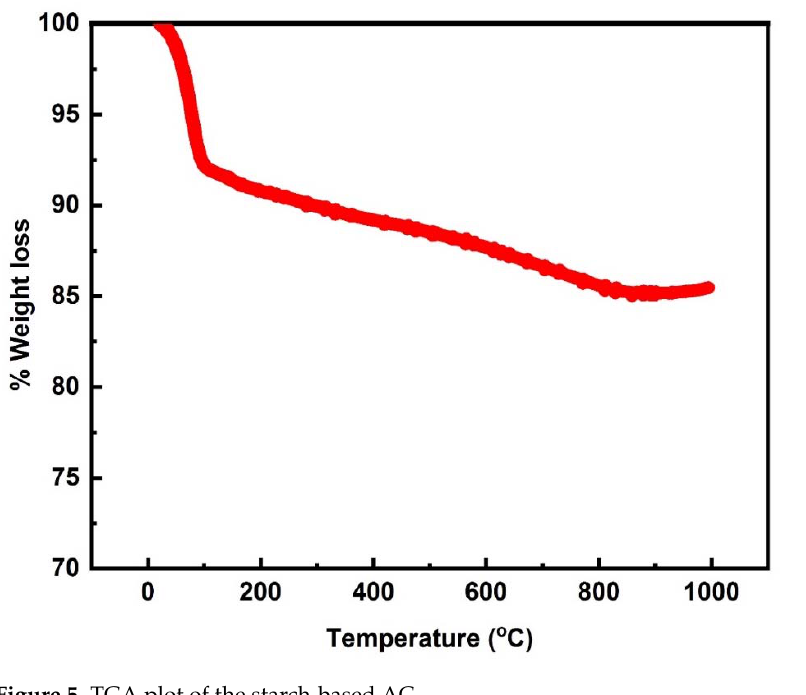
Figure 5. TGA plot of the starch-based AC.